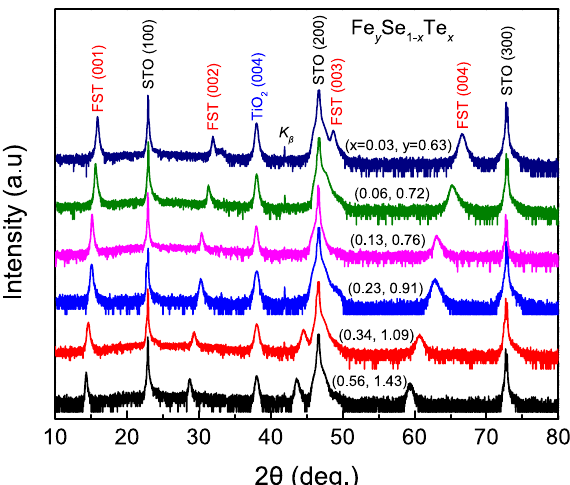
Figure 1. Semilogarithmic X-ray diffraction patterns of Fe y Se 1− x Te x thin